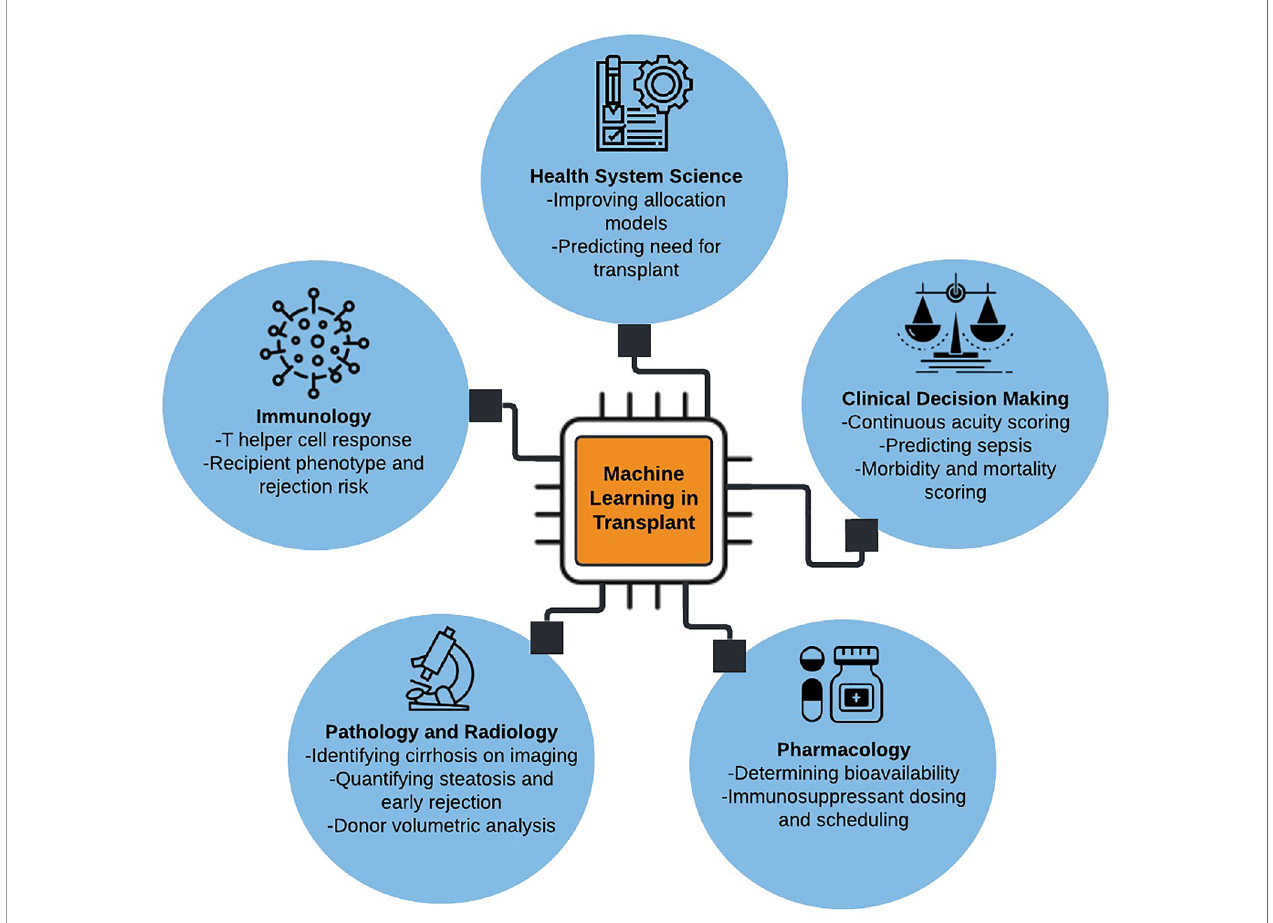
FIGURE 1 | Illustrative summary of machine learning applications in solid organ